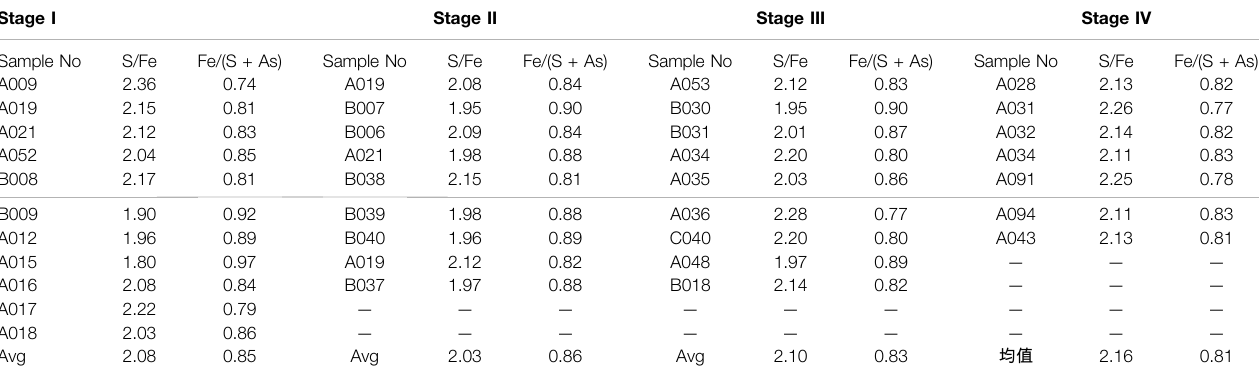
TABLE 3 | Atomic number ratio of S and Fe and Fe/(S + As) for the Zhaoxian ore-related pyrite. Stage I Stage II Stage III Stage IV